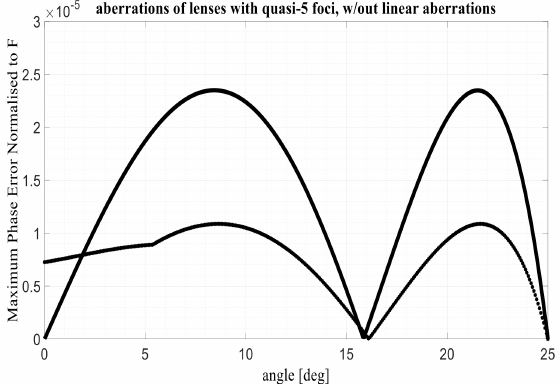
Figure 6. Normalized maximum phase error for the ~5-foci lenses with F/D = 1 before and after the removal of linear